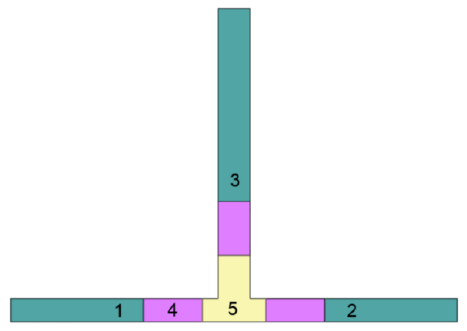
Figure 4. Domain divided into zones: (1) inlet zone of HMA and CA mixture, (2) inlet zone of AS solution, (3) reactor outlet zone, (4) transition zone between zones 1–3 and reaction zone, and (5) reaction zone. Table 4. Mesh parameters used for different reactor types.